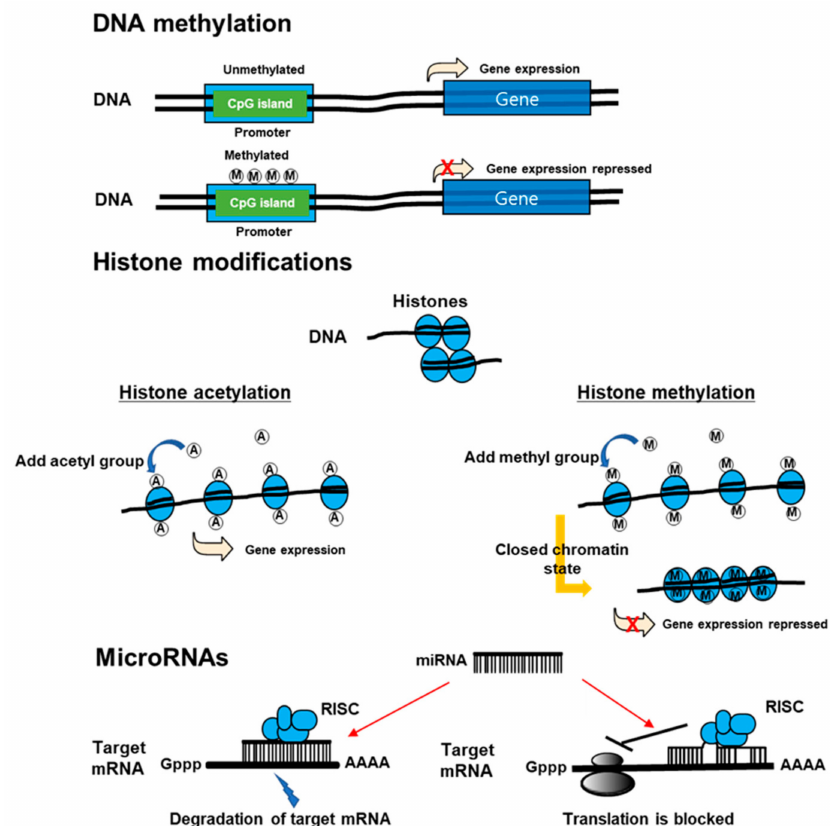
Figure 3. The mechanisms of epigenetics. DNA methylation inhibits DNA transcription. Histone modification, which modifies the interaction of DNA with histones or other DNA-binding protein complexes, regulates gene expression in a more dynamic and changing manner than does DNA methylation. Non-coding RNAs may be large ( > 200 nucleotides) or small (18–200 nucleotides). mRNA is one of the small non-coding RNAs. miRNAs suppress gene expression by selectively binding to the 3 (cid:48) non-coding region (3 (cid:48) UTR) of their mRNA targets through base-paring. miRNAs can negatively regulate gene expression by two di ff erent post-transcriptional mechanisms. RISC: RNA induced silencing